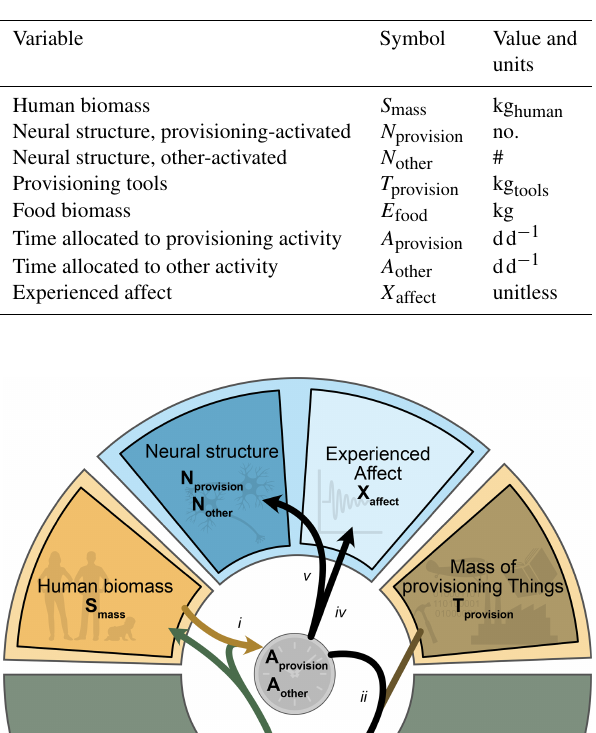
Table 1. Model state variables.